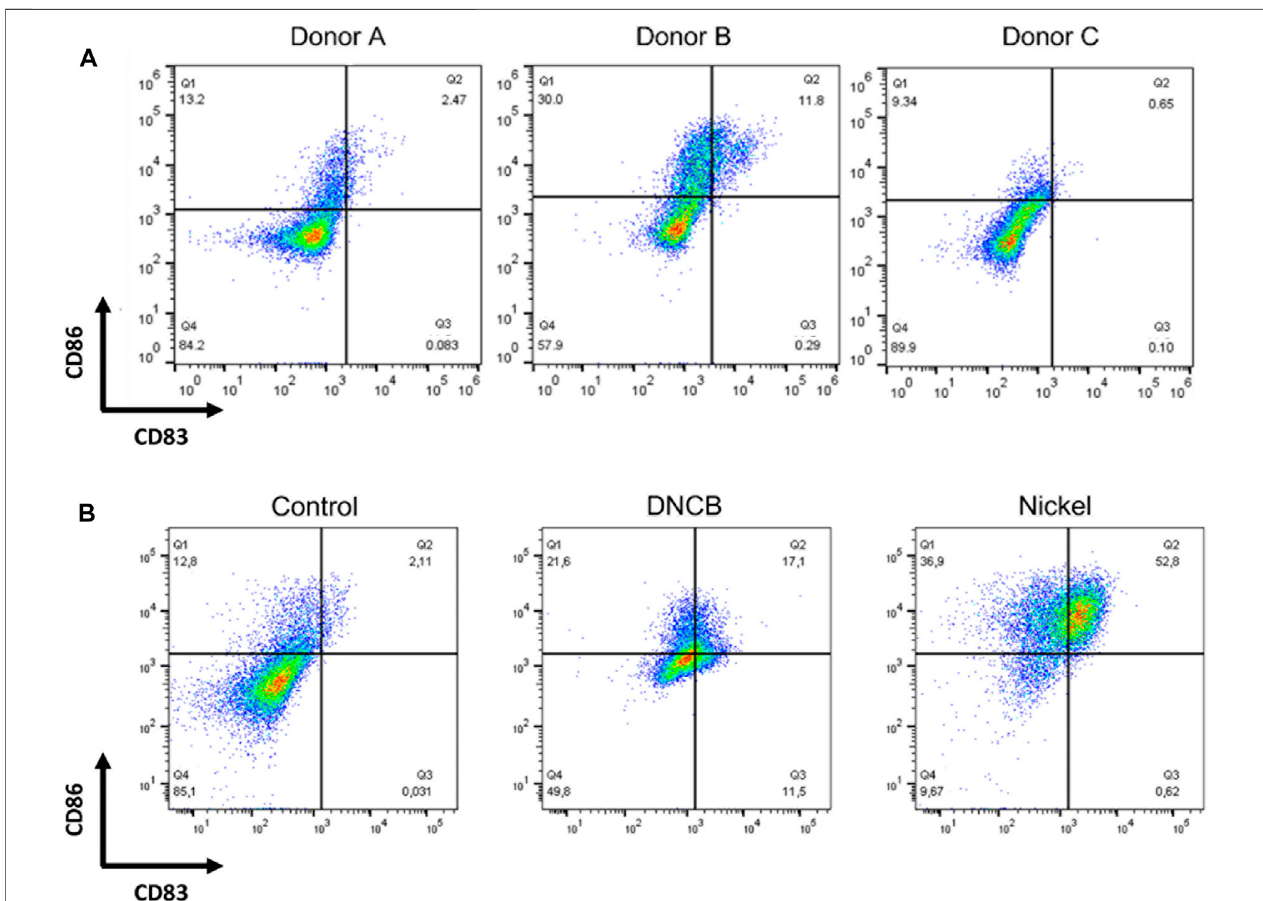
FIGURE 3 | DCs were generated by culturing CD14 + from human blood donors in the presence of GM-CSF, and IL-4 for 4 days (A) Cells were then counted, washed, and analyzed by fl ow cytometry at steady-state for the expression of the following cell surface markers: CD86 and CD83 (B) Cells were then washed and stimulated or not (control) by DNCB (5 µM) or NiSO 4 (500 μ M) for 24 h before being analyzed by fl ow cytometry for the expression of the following cell surface markers: CD86 and CD83. Quadrant position was determined using isotype antibodies for each condition of stimulation. Numbers in each quadrant represent cell